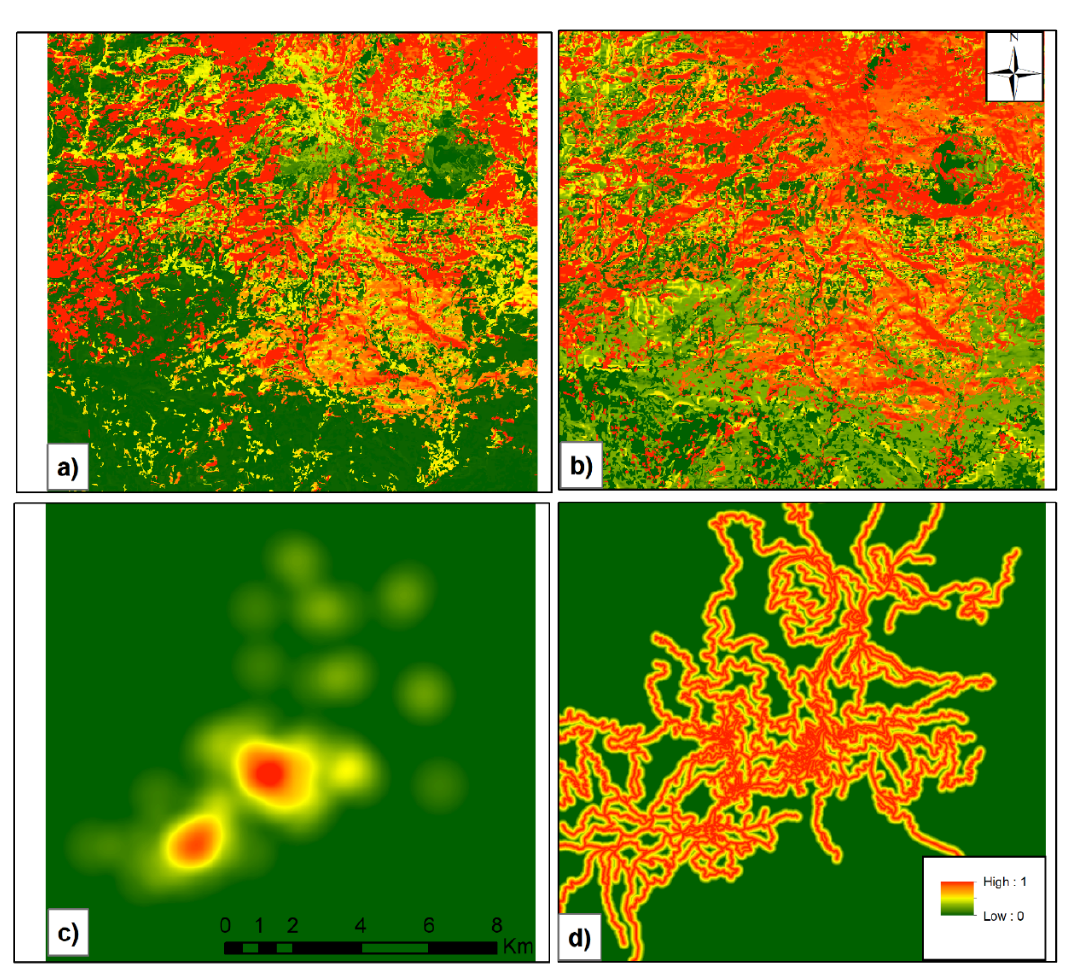
Figure 3. Components of the Fire Danger Index (FDI) used in the study. FI (Fireline Intensity) ( a ), ROS (Rate of Spread) ( b ), PH (Pyric History) ( c ), HI (Distance to Roads) ( d ).